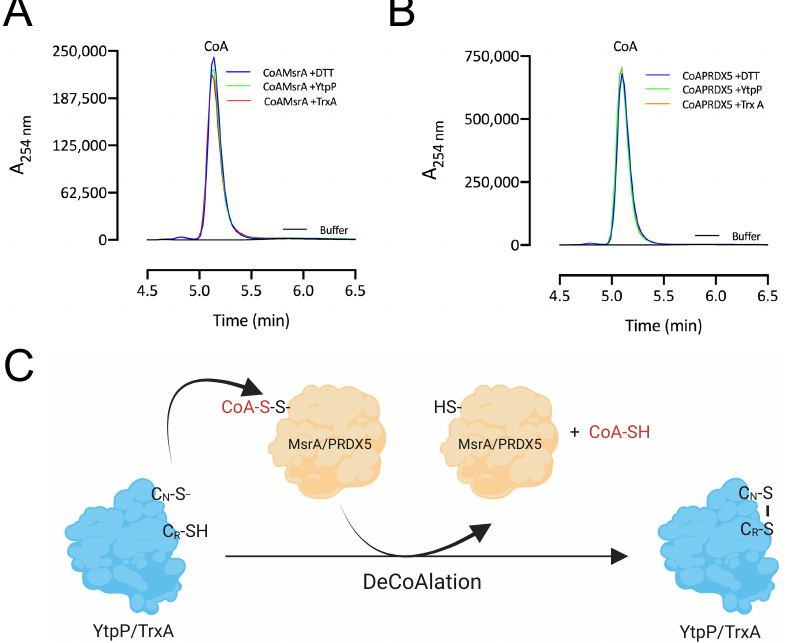
Figure 6. DeCoAlation of CoA–MsrA and CoA–PRDX5 by YtpP and TrxA. Release of CoA